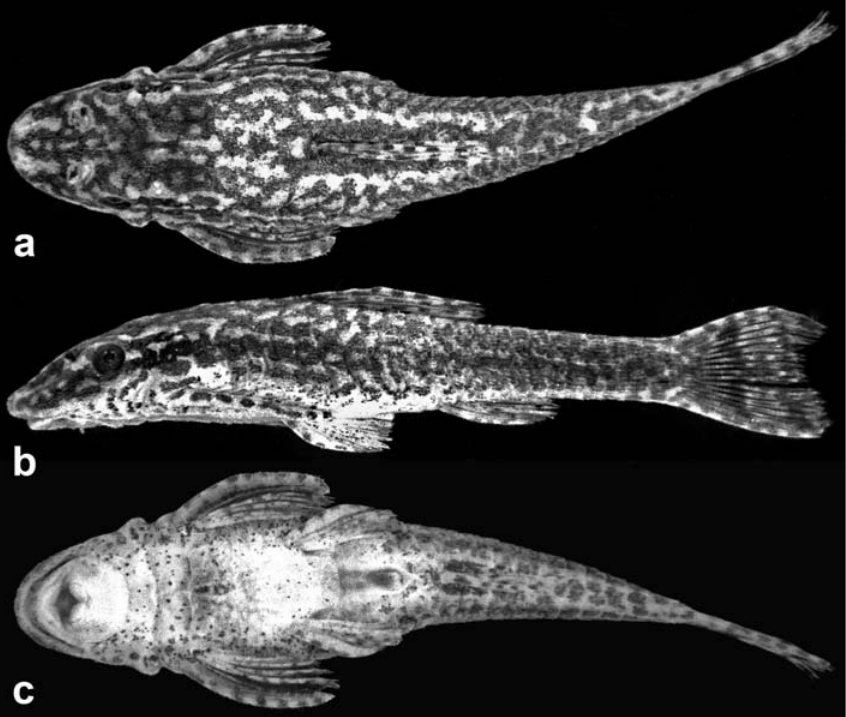
Fig. 1. Otothyropsis marapoama , holotype, LIRP 5640, 38.5 mm SL. Brazil, São Paulo, rio Tietê basin, Município de Marapoama, ribeirão Cubatão, off the road between Marapoara and Elisiário (21º11’35"S 49º07’22"W). Dorsal (a), lateral (b), and ventral (c)